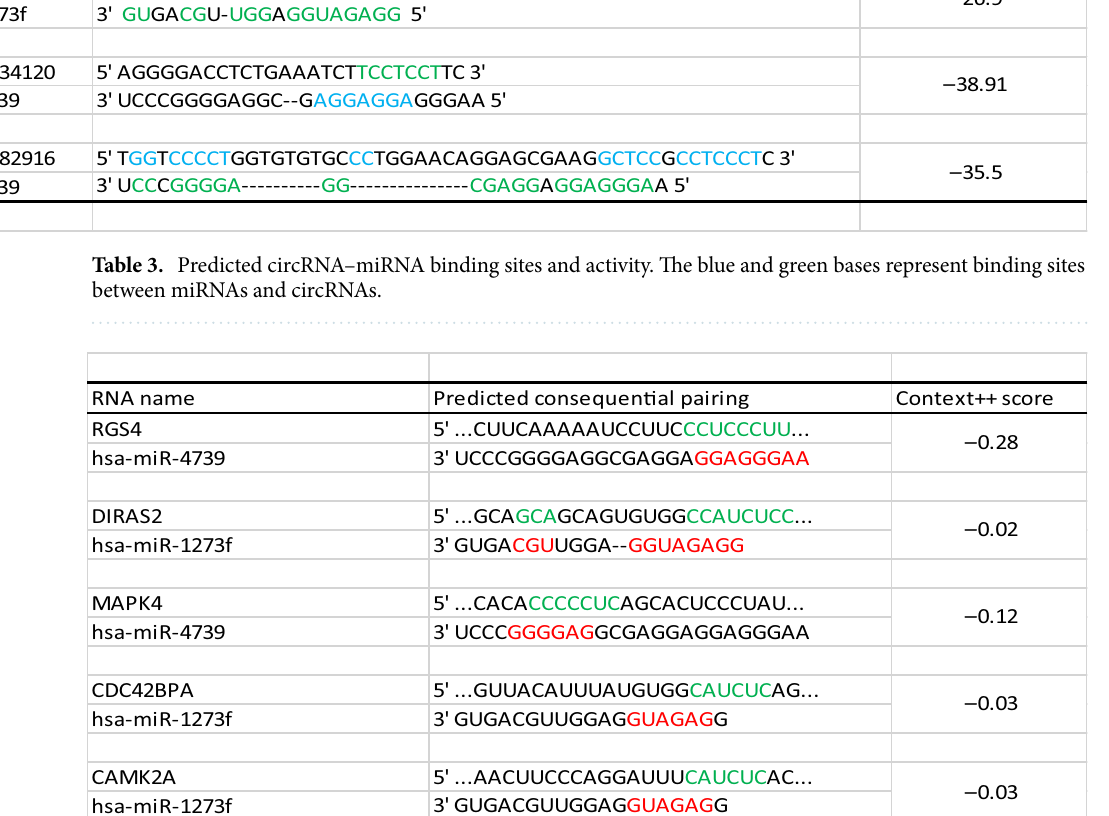
Table 4. Predicted hub gene–miRNA binding sites and activity. The red and green bases represent binding sites between miRNAs and mRNAs.